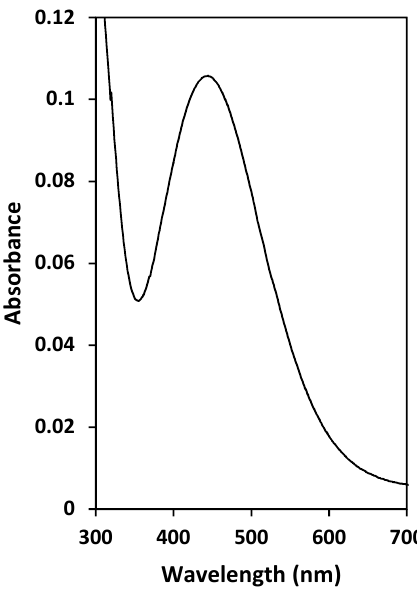
Figure 8. UV-Vis spectrum of the back-extraction solution (6 mol L − 1 H 2 SO 4 + 1 v / v % H 2 O 2 ), confirming the presence of the VO(O 2 ) + species